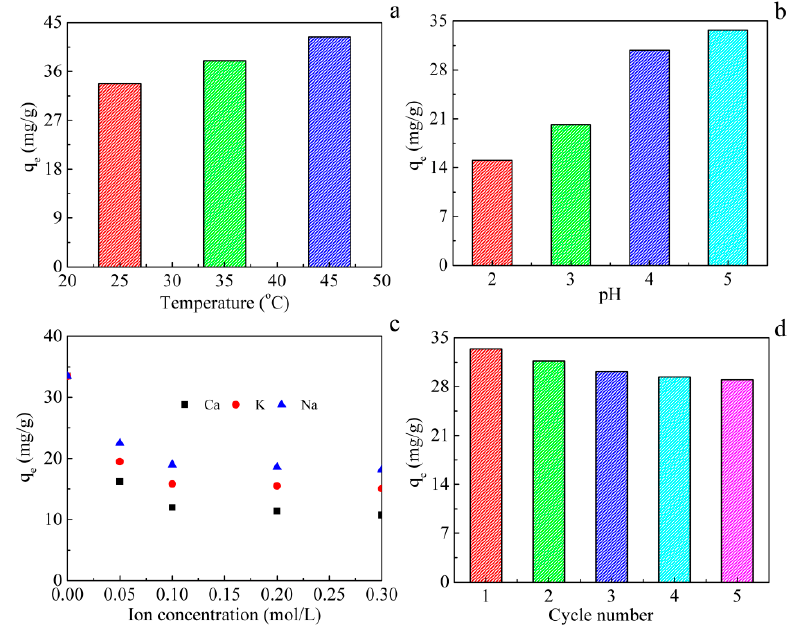
Figure 4. Effects of temperature ( a ), pH ( b ), cationic ions ( c ), and recycling ( d ) on the Pb(II) adsorbing capacity of PEI-functionalized Fe 3 O 4 MNPs.